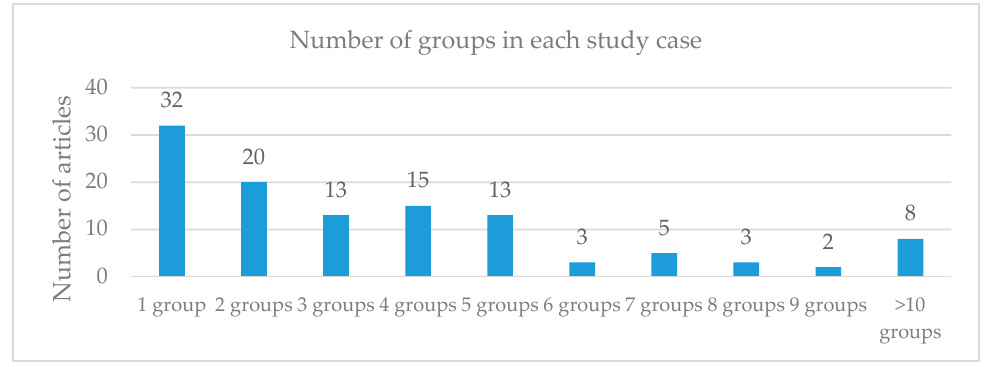
Figure 5. Number of groups in each study case.